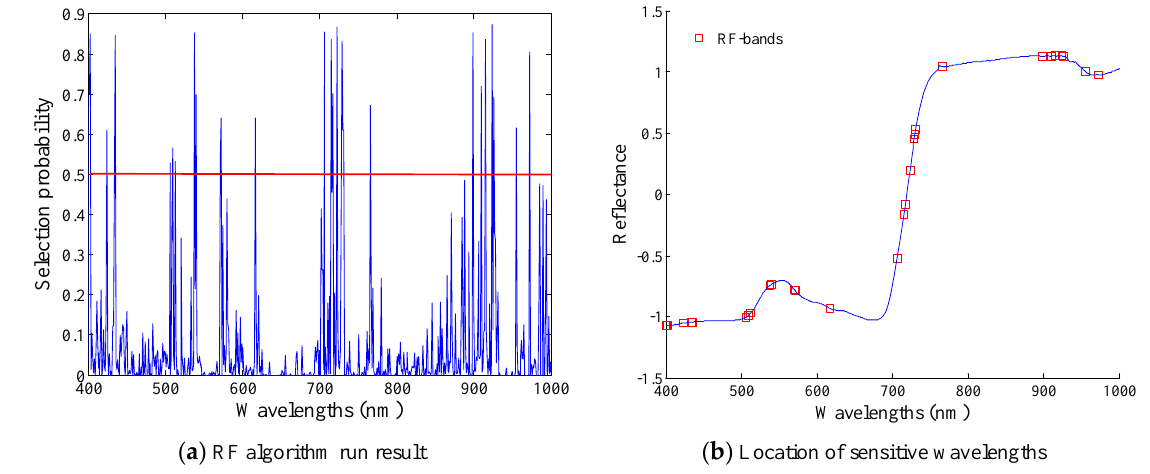
Figure 7. Growth stage-sensitive wavelengths selection result of potato using SPA.